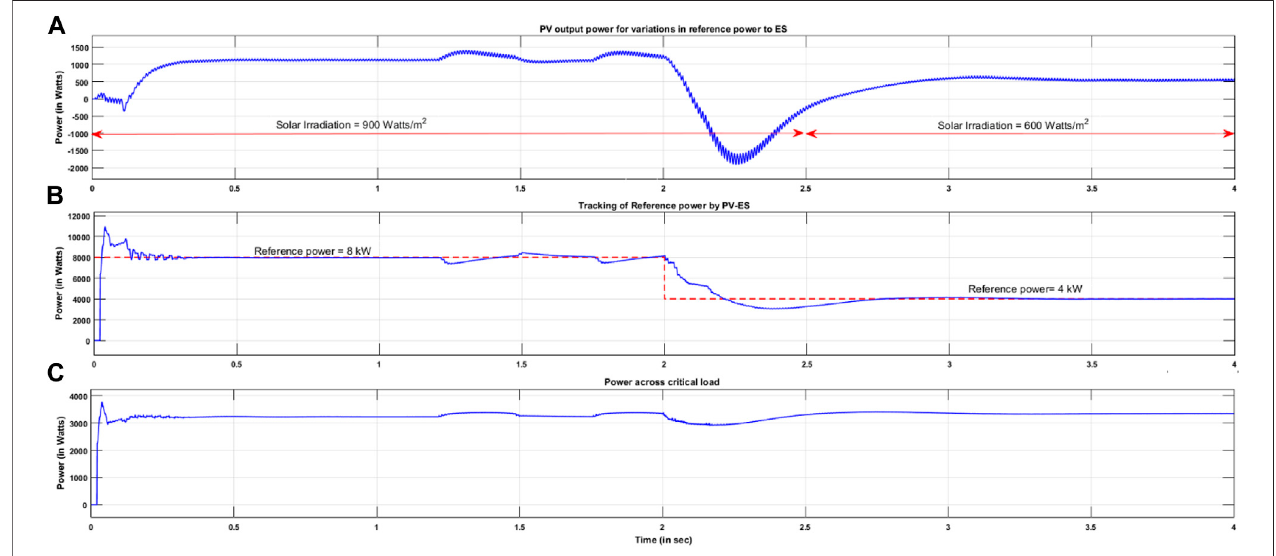
FIGURE 8 | Performance of PV-ES under varying solar